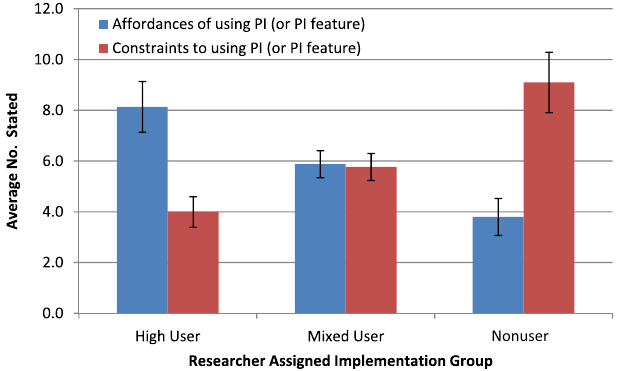
FIG. 2. Number of affordances and constraints expressed by interviewees in each researcher-assigned user